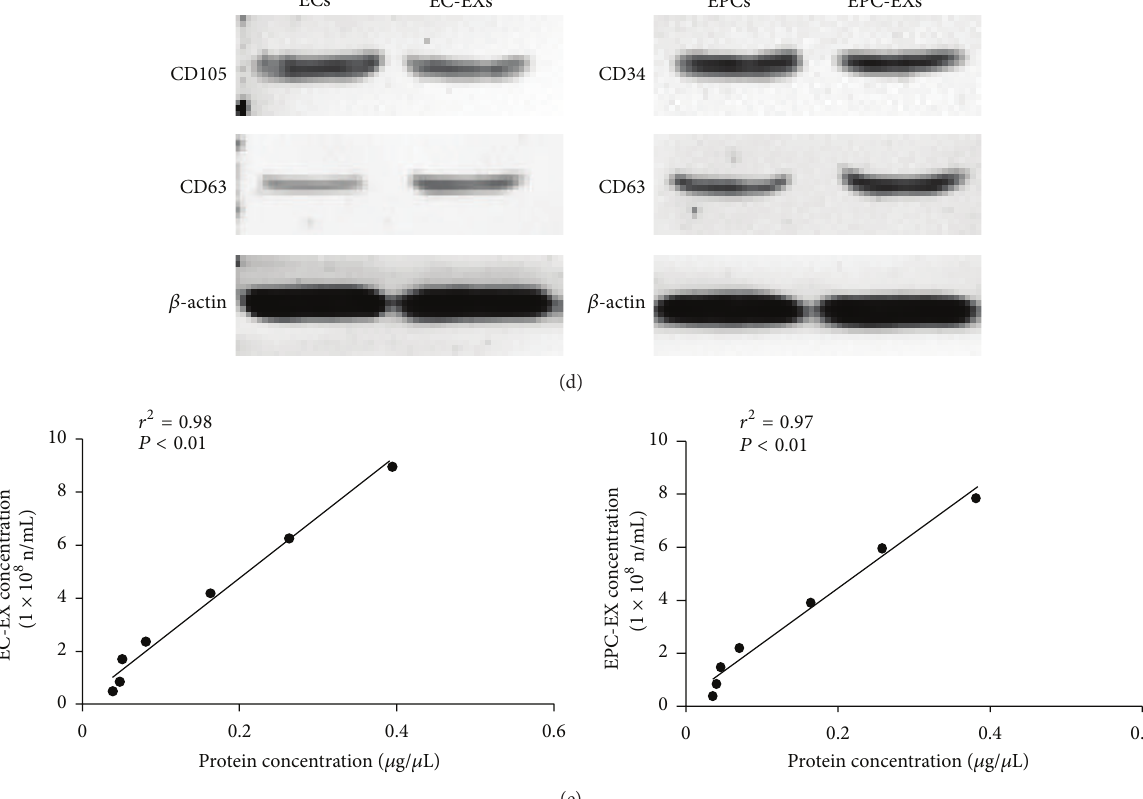
Figure 1: Characterization of EC-EXs and EPC-EXs. (a) Representative NTA plot showing the size distribution of 100nm and 200 nm polystyrene beads. (b) Representative NTA plots show size/concentration distribution of particles in the EX-depleted EC and EPC medium and of EC-EXs and EPC-EXs. Black solid line: 100nm landmark; black dash line: 200 nm landmark. (c) TEM micrographs of EXs. (d) Representative western blot bands showing the expression of CD63, CD105, and CD34 in EXs and their corresponding parent cells, ECs and EPCs. (e) The correlation between EXs and their protein